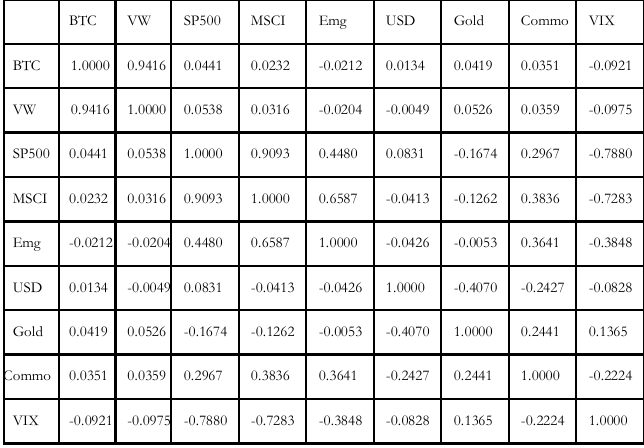
Table 9: Correlations between daily returns of cryptocurrencies and traditional assets (Jan 2015 - Feb 2018)